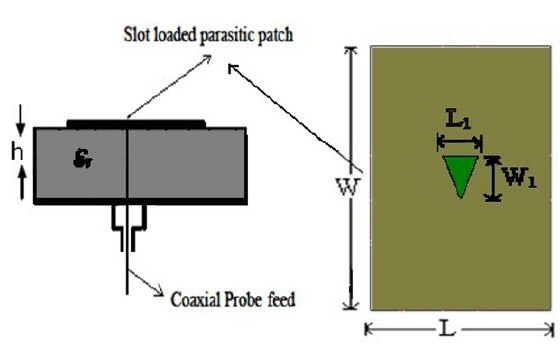
Figure 1. Geometry of proposed microstrip